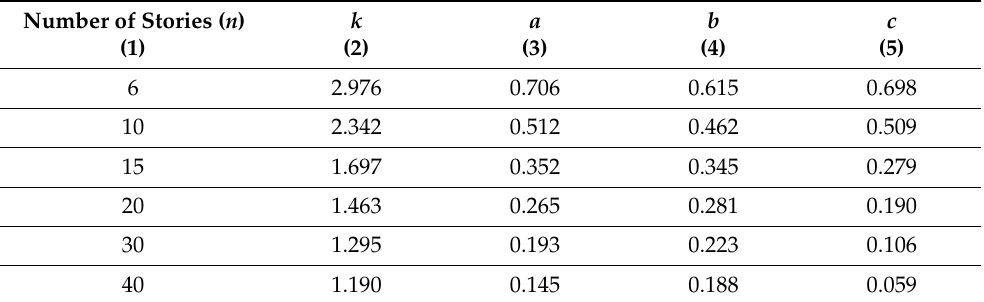
Table 1. Values of k , a , b , and c for Equation (2) (adapted with permission from [12]. 1996, American society of civil engineers)